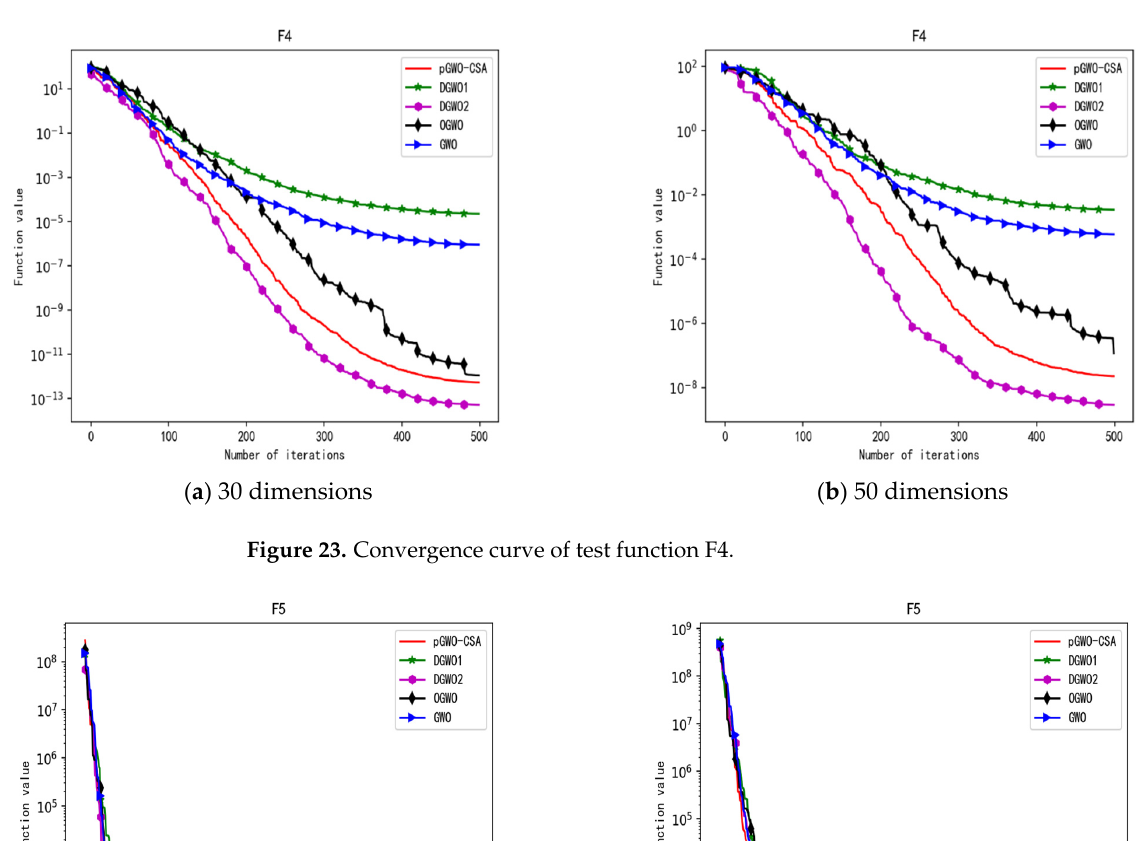
Figure 22. Convergence curve of test function F3.